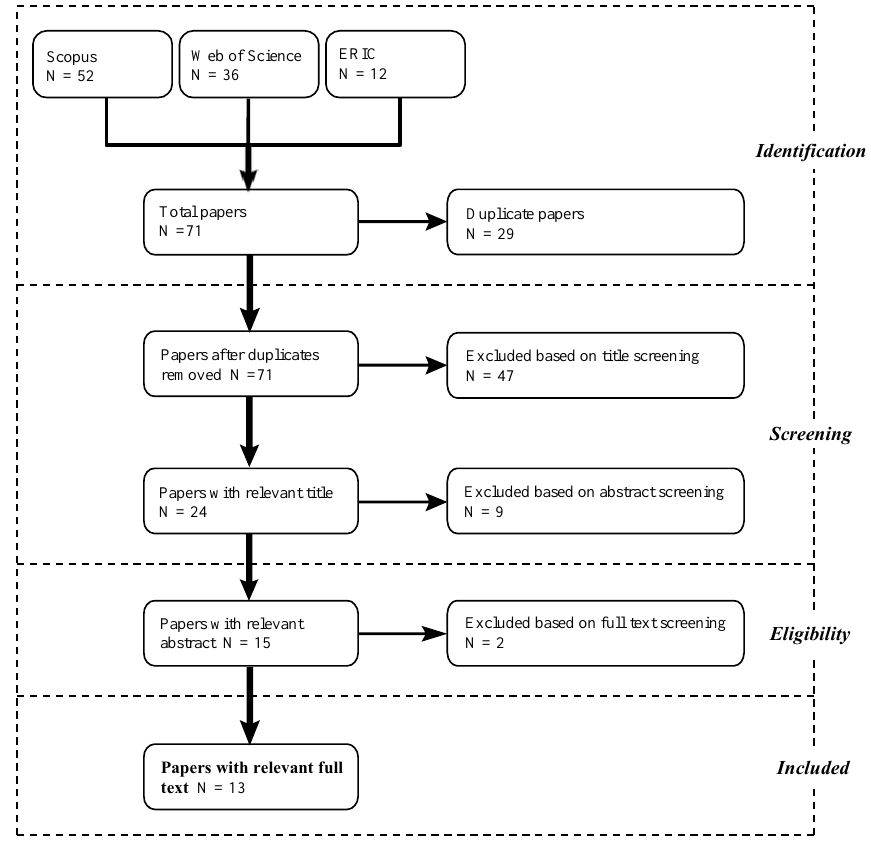
Figure 1. PRISMA flow diagram depicting results of search, screening and selection processes.